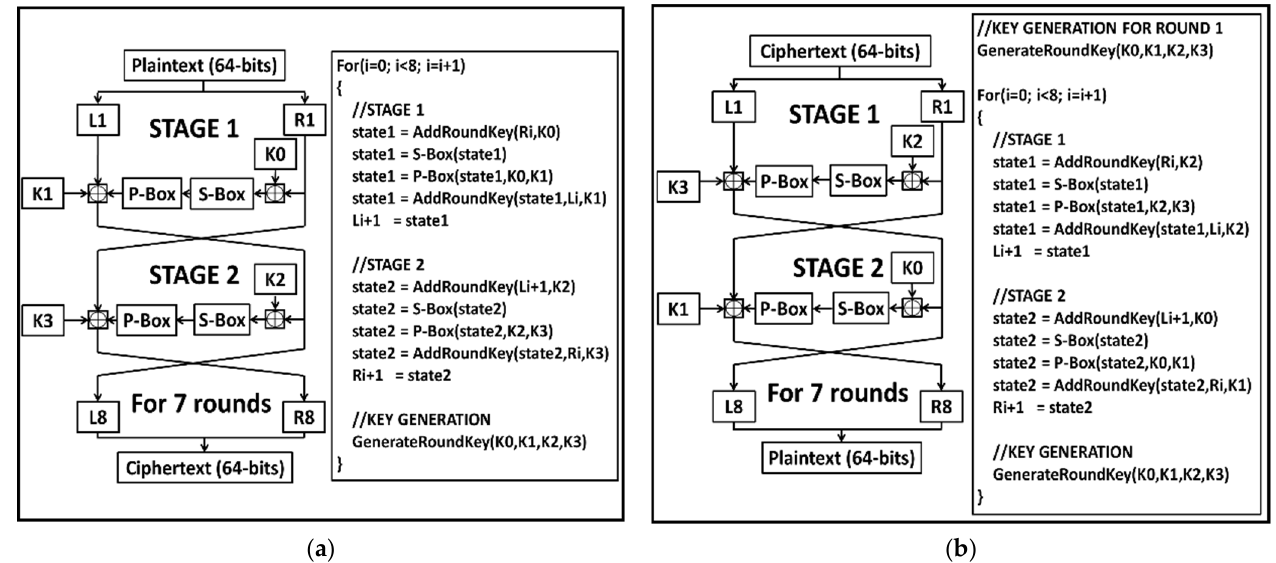
Figure 5. Top level description of NEW algorithm: ( a ) NEW encryption routine; ( b ) NEW decryption routine.